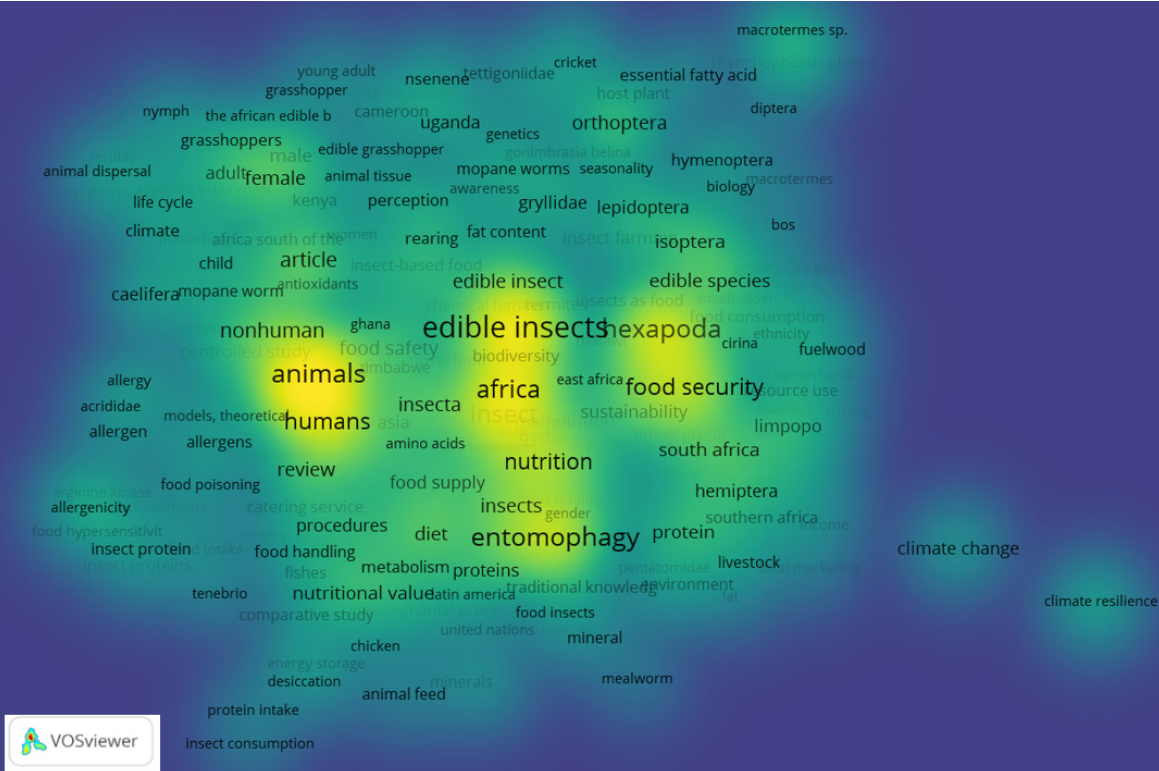
Figure 4. Density visualisation of key-word co-occurrence for edible insect studies in Africa.